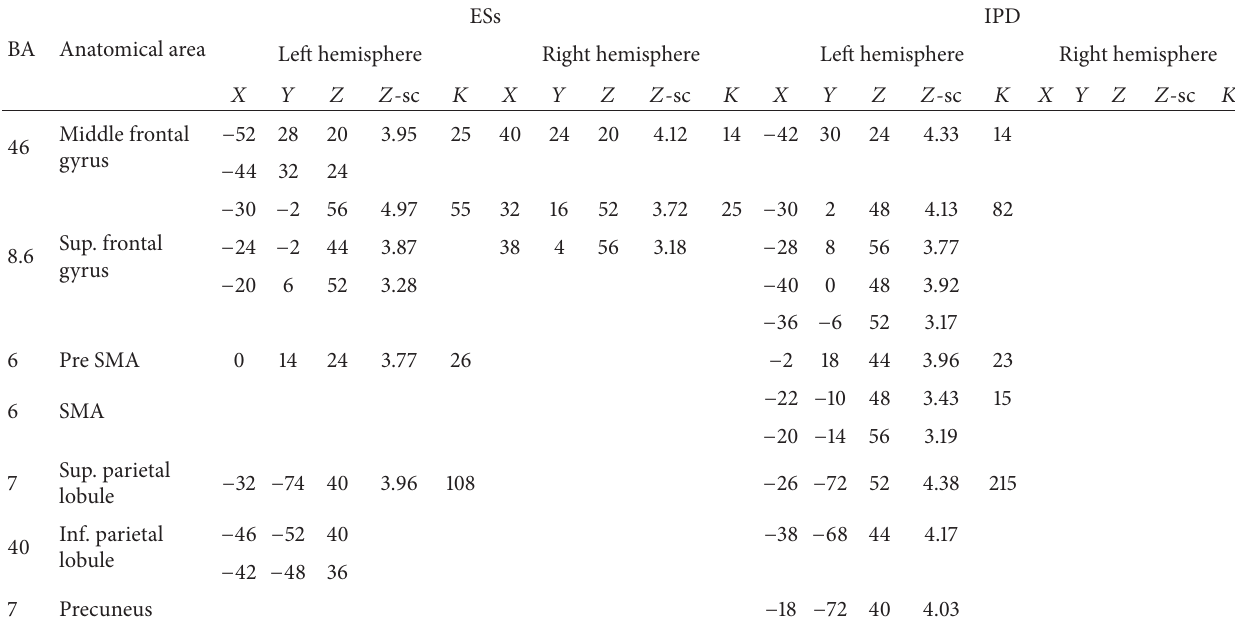
Table 3: Within-groups comparisons SWMT baseline.